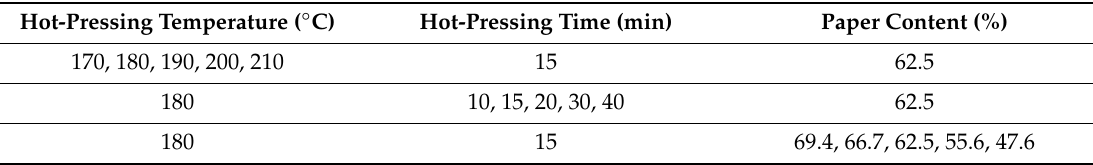
Table 1. Single factor test